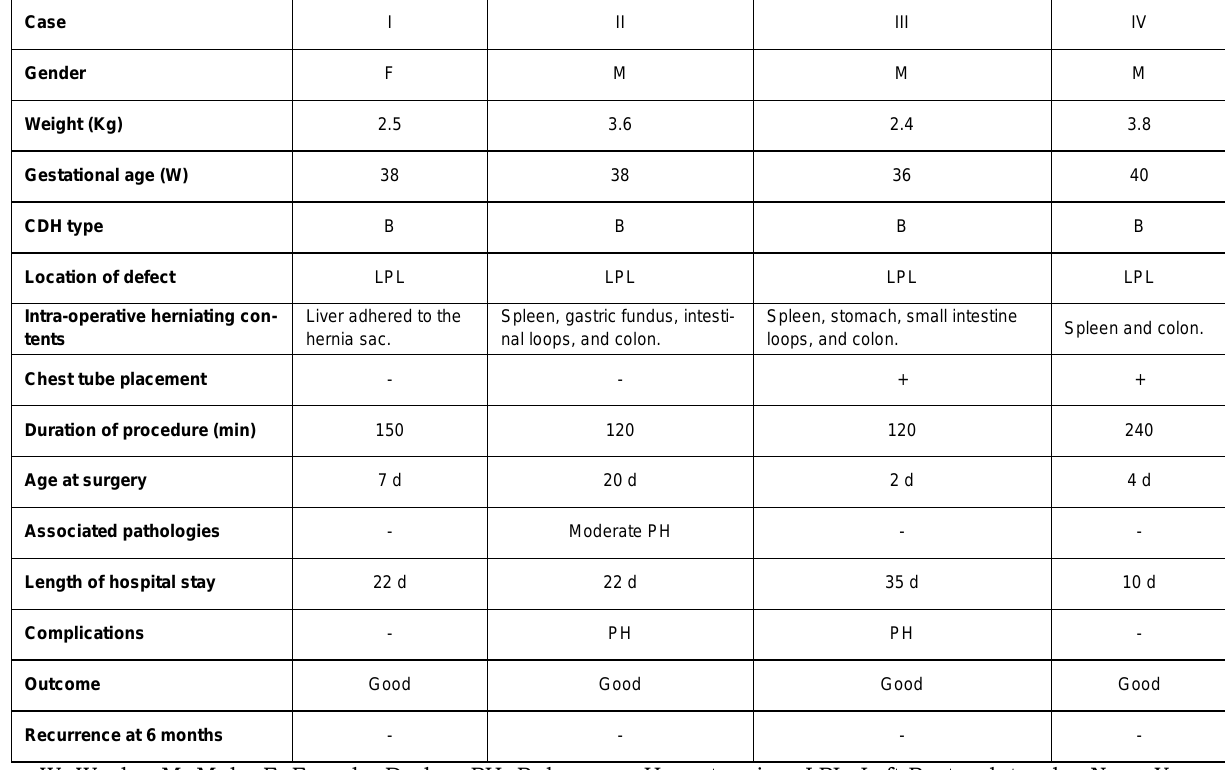
Table 1: Characteristics of patients with